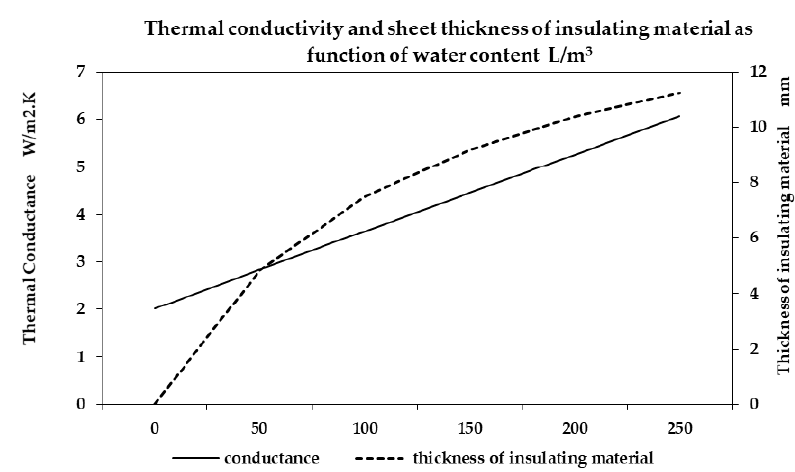
Figure 4. thermal conductance as a function of water content and leaf thickness of insulating material.